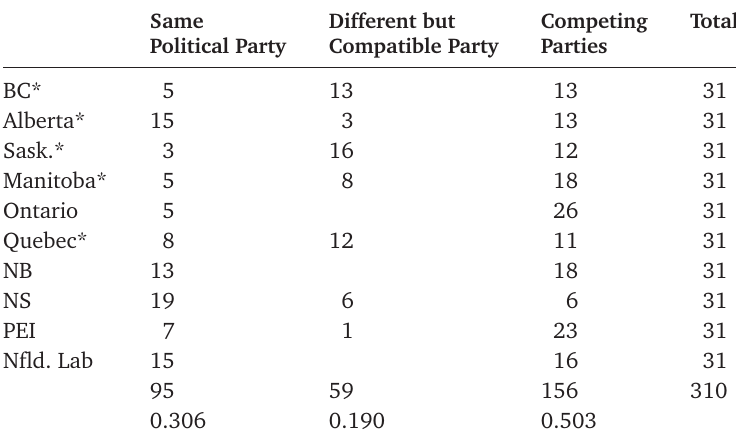
Table 5. Partisan Composition of Federal, Provincial Governments,